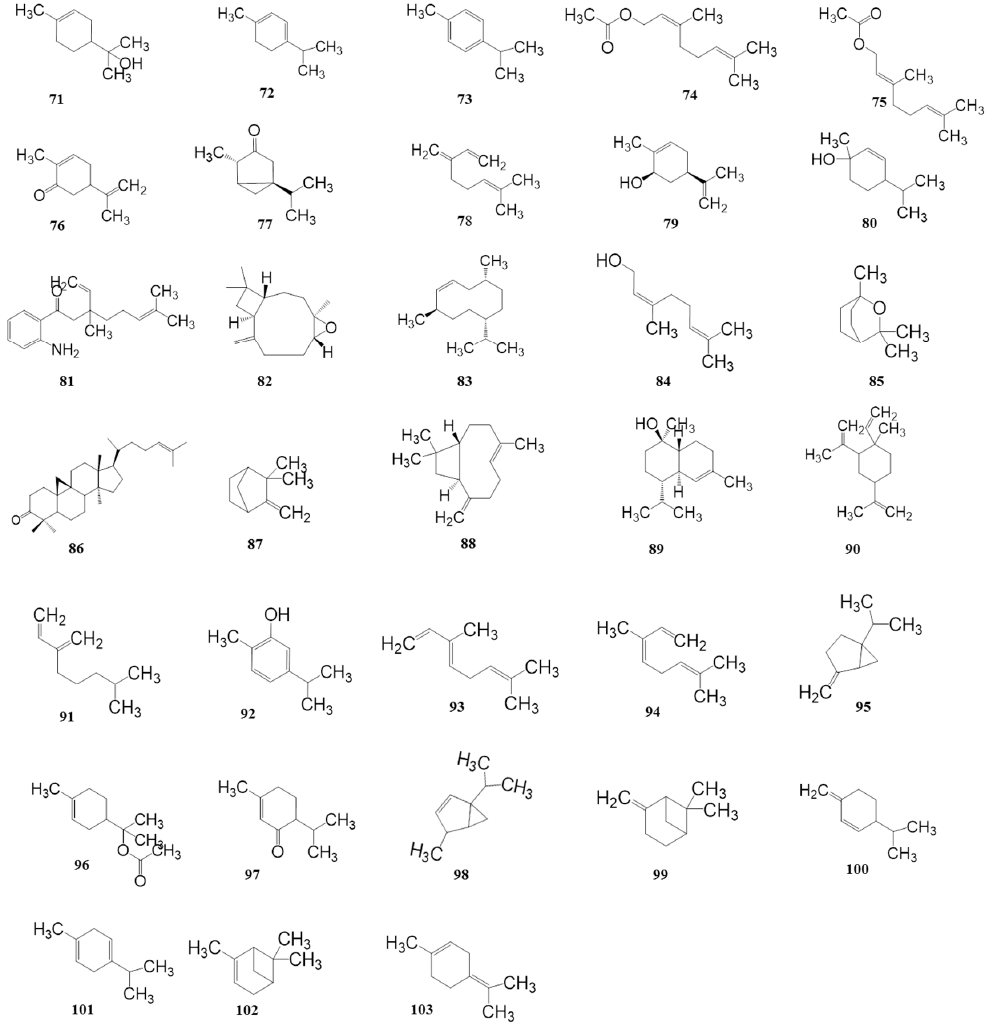
Figure 4. Chemical structures of terpenoids in Z. bungeanum . Table 3. Terpenoids isolated from Z. bungeanum ( 36 – 103 ).